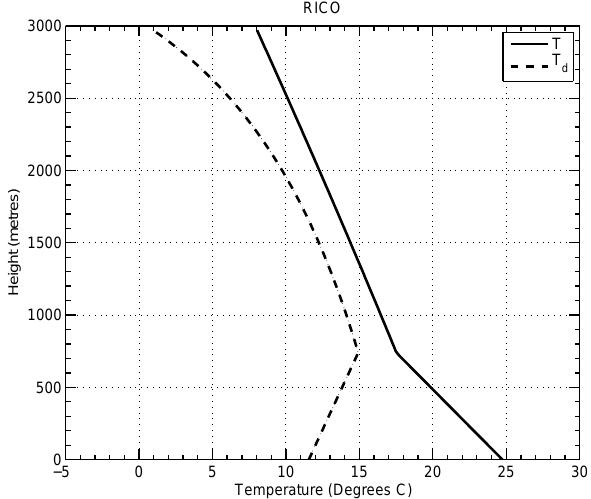
Fig. 2. Temperature (solid) and dew-point temperature (dashed) profiles in ◦ C taken from the RICO model intercomparison, and used to initialise the models. The additional profiles, “RICO-2” and “RICO-5”, are obtained by cooling the RICO profile uniformly in height by 2 ◦ C and 5 ◦ C respectively under a fixed relative humidity.